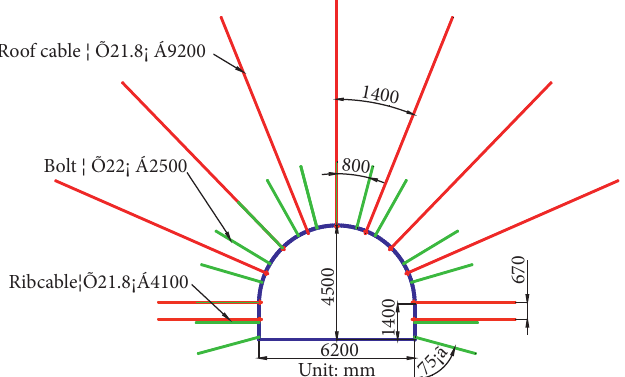
Figure 4: The primary support scheme.